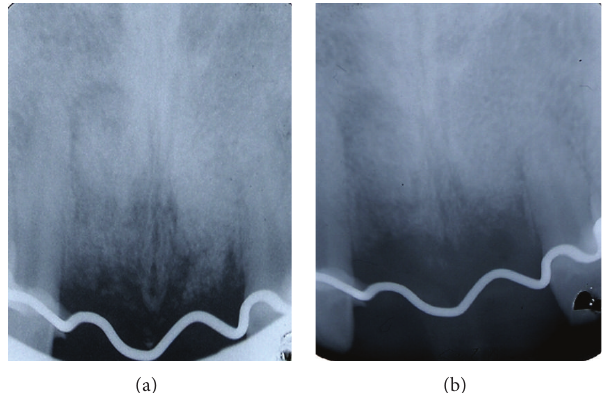
Figure 5: A periapical radiograph was taken at 3 (a) and 6 months (b) from the socket preservation. After 6 months, a limited bone loss was showed related to the steel wire of the interim prosthesis.